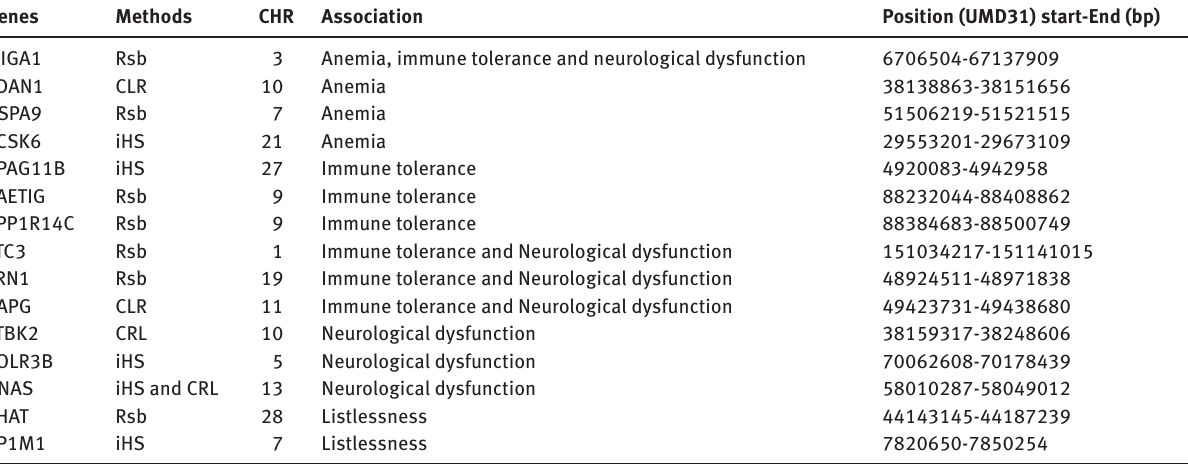
Table 2: Candidate signature genes play a major role in the natural tolerance attributes of Sheko breed against trypanosomosis. Modified from Mekonnen et al .